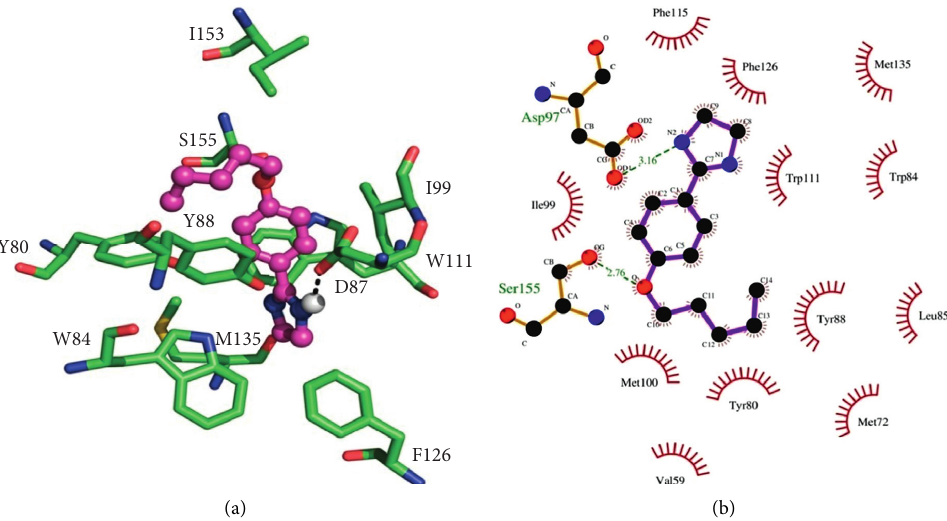
Figure 9: 3D portrayal of the π - π interactions between the phenyl ring of 13 and W111.